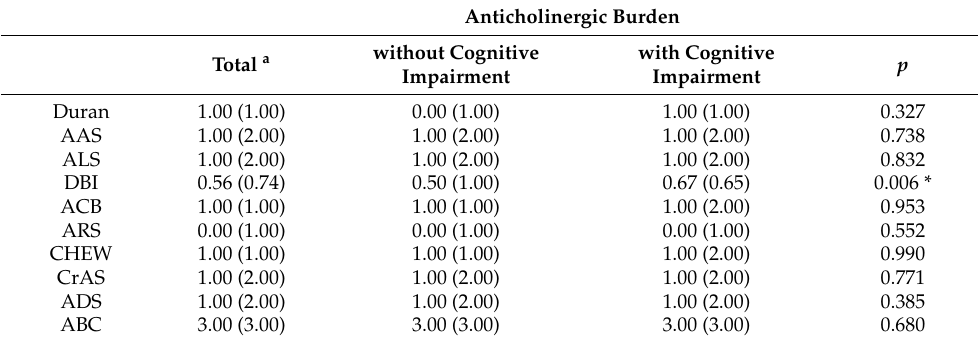
Table A3. Anticholinergic burden by all the scales in total patients, with and without cognitive impairment.